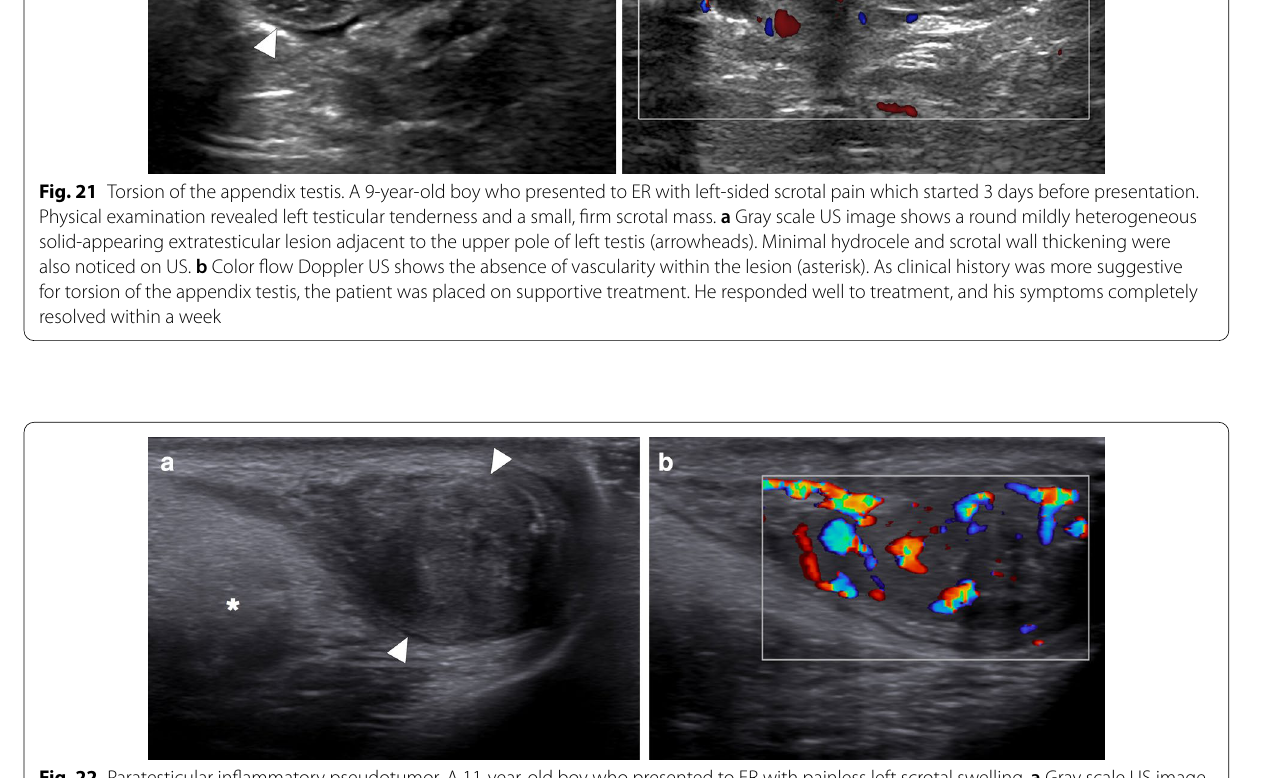
Fig. 22 Paratesticular inflammatory pseudotumor. A 11-year-old boy who presented to ER with painless left scrotal swelling. a Gray scale US image demonstrates a heterogeneous, predominantly hypoechoic extratesticular lesion (arrowheads), adjacent to the lower pole of the left testis (asterisk). Also noted were a few scattered intralesional calcifications. b Color Doppler US exam shows widespread internal vascularity. The findings suggest an intrascrotal-extratesticular tumor, such as rhabdomyosarcoma. Surgical removal of the tumor, with preservation of the left testis, instead